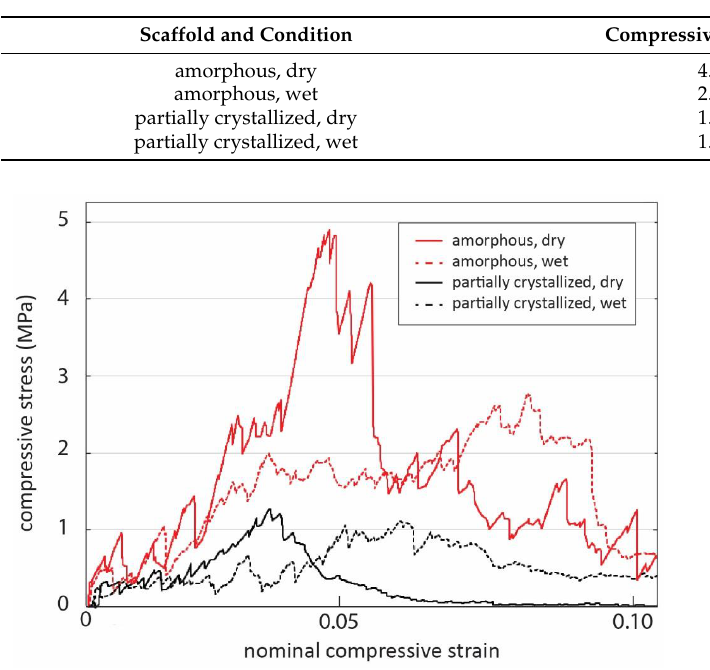
Figure 7. Representative stress – strain curves for amorphous scaffolds in compressive testing, with partially crystalline scaffolds as reference. The scaffolds that were tested in wet condition had been immersed in SBF for 5 min immediately prior to